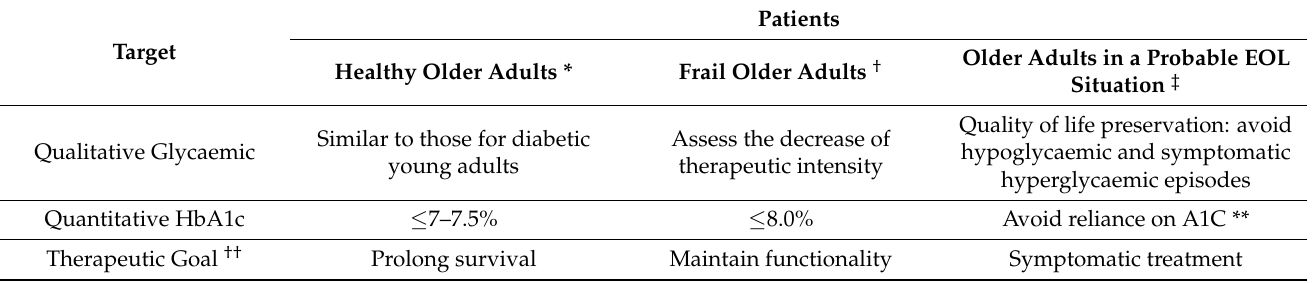
Table 1. HbA1c target according to each patient profile.